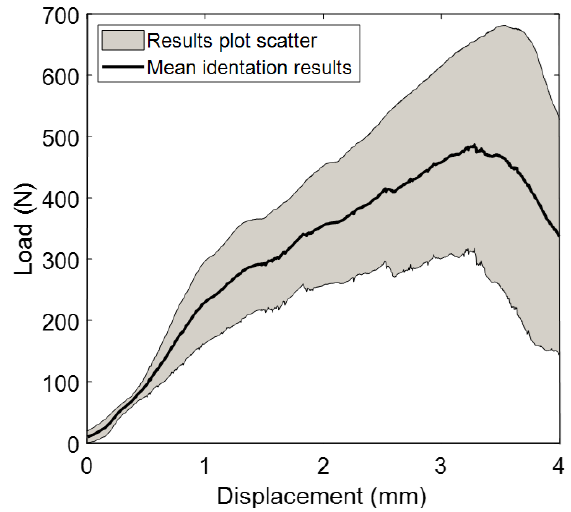
Figure 9. Load – displacement curves from roller indentation tests.